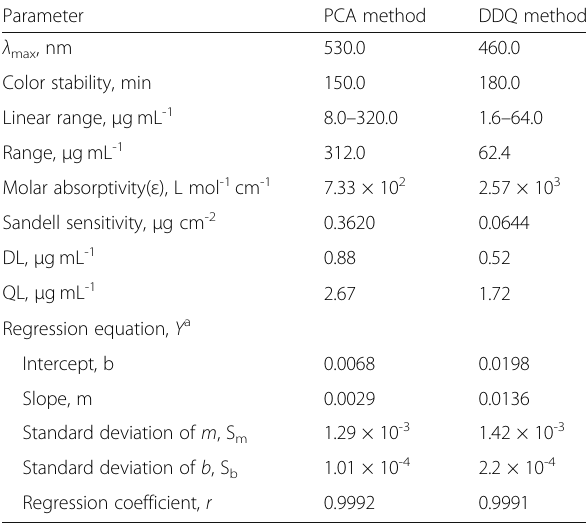
Table 4 Results in evaluation of robustness and ruggedness of PCA and DDQ methods (expressed in %RSD)